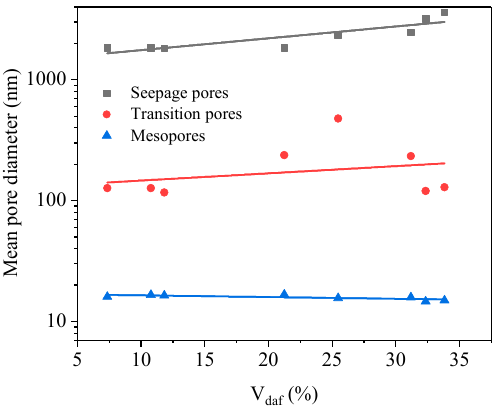
Figure 9. Relationship between V daf and pore size.